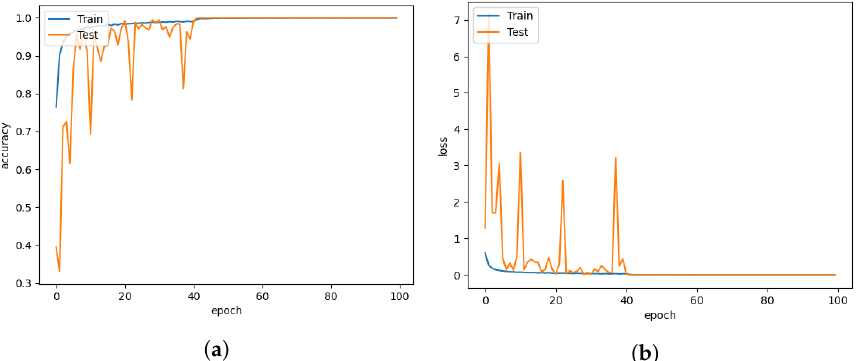
Figure 16. DISubNetV1 for learning rate = 0.001. ( a ) Model accuracy. ( b ) Model